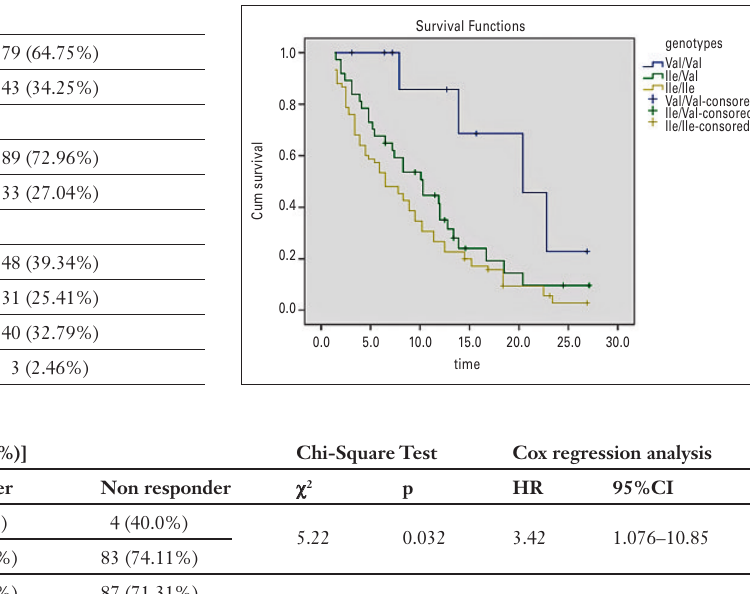
Association between GSTP1-105 genotypes (Ile/Ile and Ile/Val as separated group) and overall survival in patients with metastatic colorectal cancer receiving 5-FU/oxaliplatin chemotherapy. The vertical hash marks denote the time of last follow-up for those patients who were still alive at the time of the data